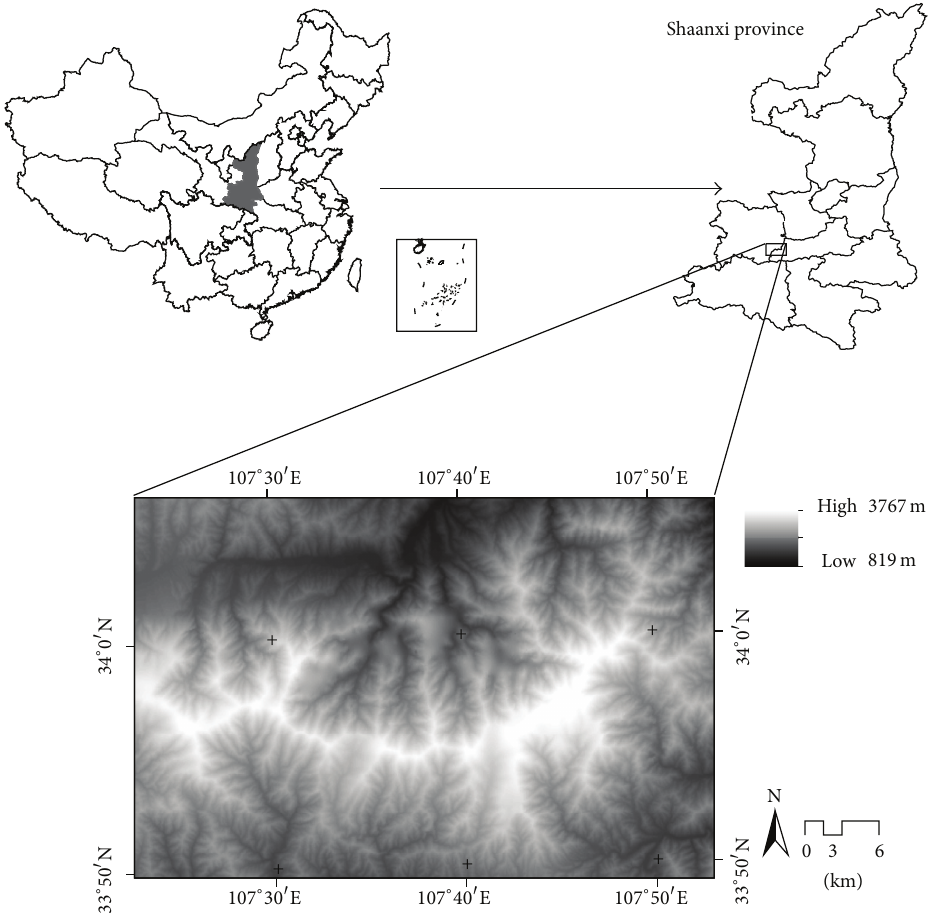
Figure 1: Geographic location and topography of Taibai Mountain.